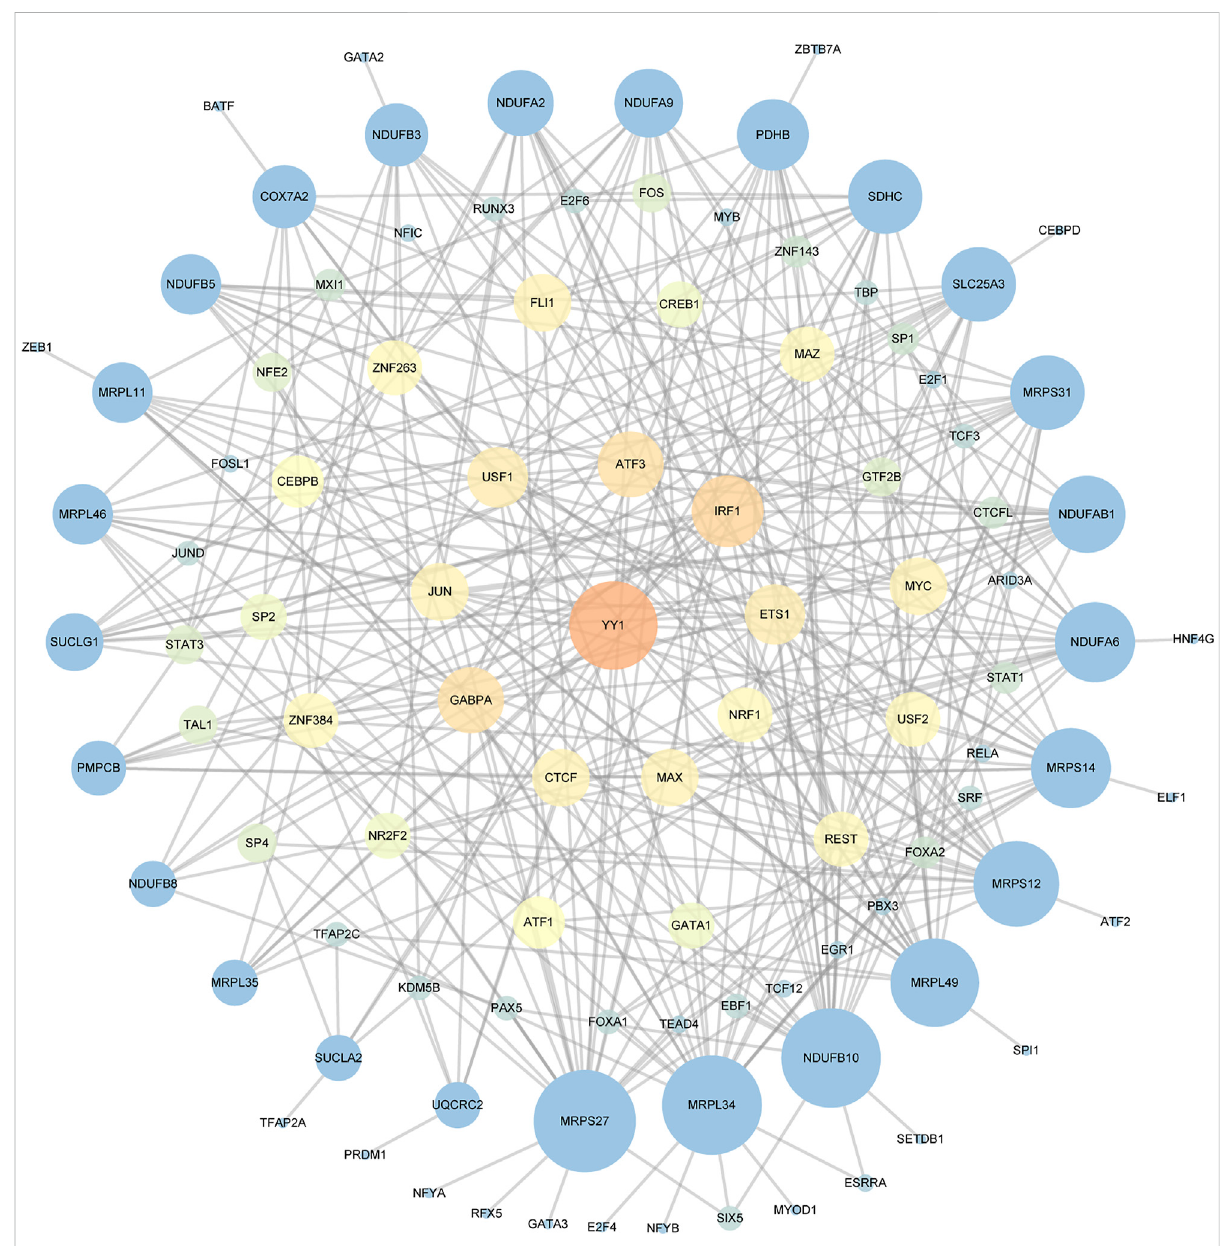
FIGURE 4 The TF-key Gene Network. Different colors and sizes of nodes represent different degrees. The larger and brighter the node becomes, the greater the degree